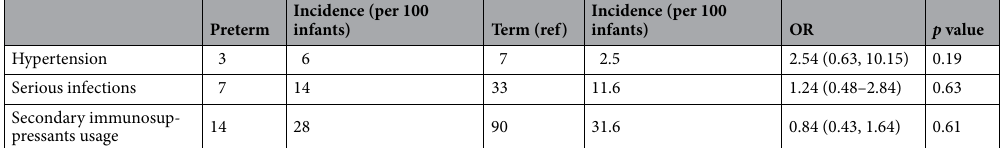
Incidence (per 100